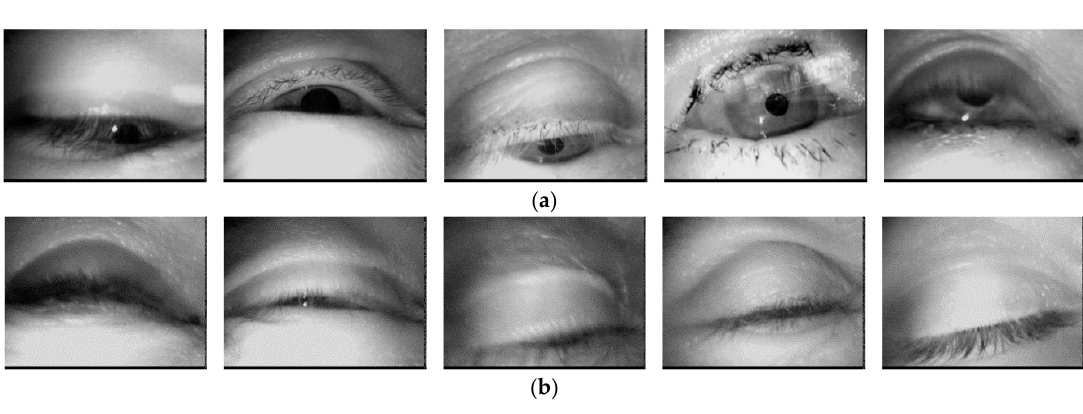
Figure 12. Examples of correct classification of open and closed eye images of open database of NIR eye images using the proposed method. ( a ) Open eye images; ( b ) Closed eye images.